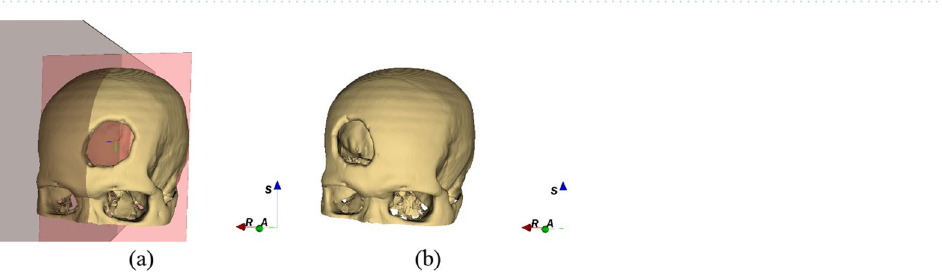
Figure 3. Mirroring the skull defect area along the midsagittal plane ( a ) create the midline on the sagittal plane ( b ) mirror the surface between the left and right sides of skull to obtain a mirrored whole skull. S, R, A stand for superior, right, and